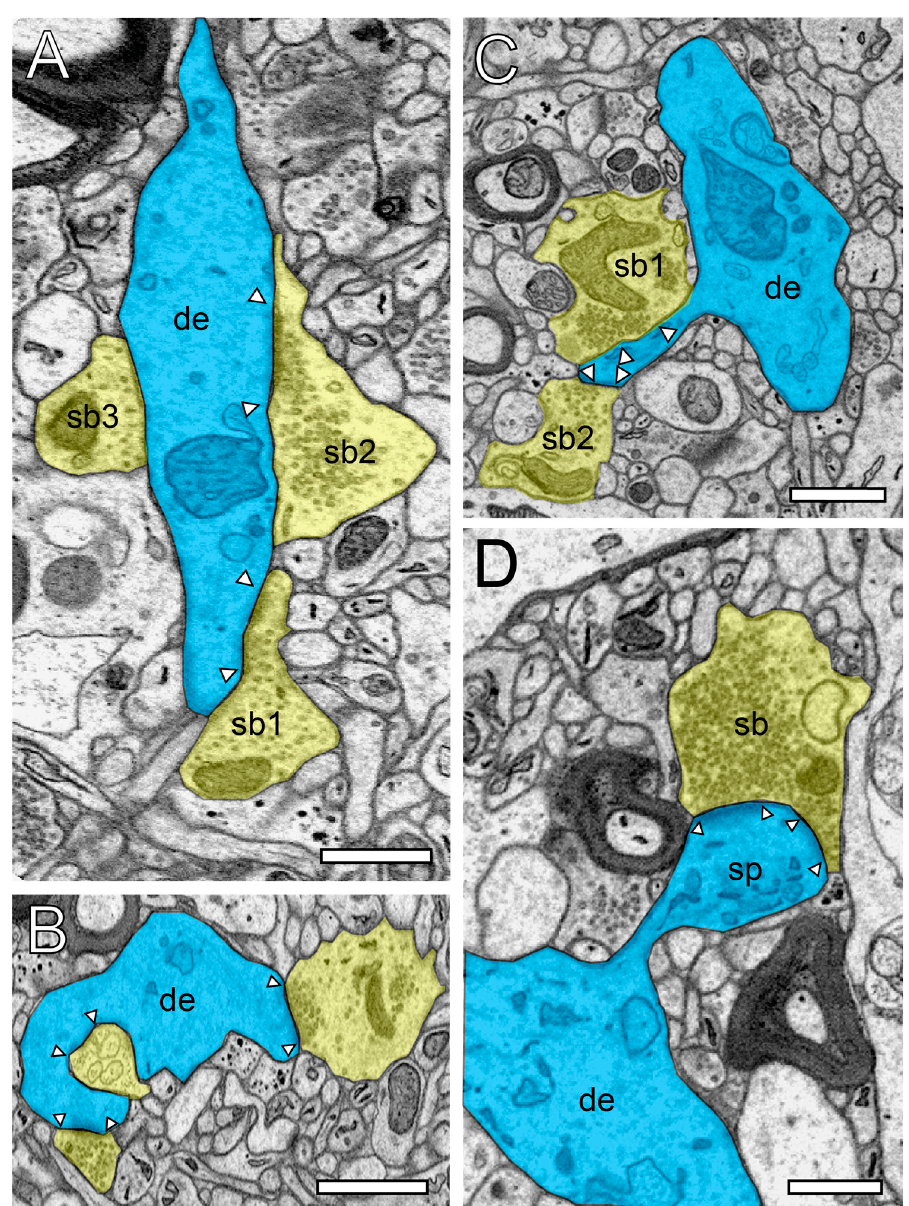
Figure 2. Structural characteristics of SBs and their target structures in the human TLN as revealed by FIB-SEM. ( A ), Large dendrite (de, transparent blue) with three terminating SBs (sp1–sp3, transparent yellow of different shape and size in L6 of the gyrus temporalis medialis. In two SBs (sb1, sb2), a clear AZ is visible, whereas sb3 is lacking an AZ. ( B ), Small caliber dendrite (de) receiving synaptic input from three SBs, one of which invaginating the dendrite in L5 of the gyrus temporalis medialis. ( C ), Elongated spine (sp) emerging with a long spine neck from a dendrite (de) in L3 of the gyrus temporalis medialis with two opposing SBs (sb1, sb2) terminating on the spine head. AZs are marked by arrowheads. Same color code as in A. ( D ), Large mushroom spine (sp) with a short spine neck originating from a dendritic segment (de) in L2 of the gyrus temporalis inferior receiving input from a relatively large end terminal SB with synaptic vesicles (SVs) distributed over the entire terminal. In all images, AZs are marked by arrowheads, and the same color code is used as in ( A ). Scale bar in ( A – D ), 0.5 µm.